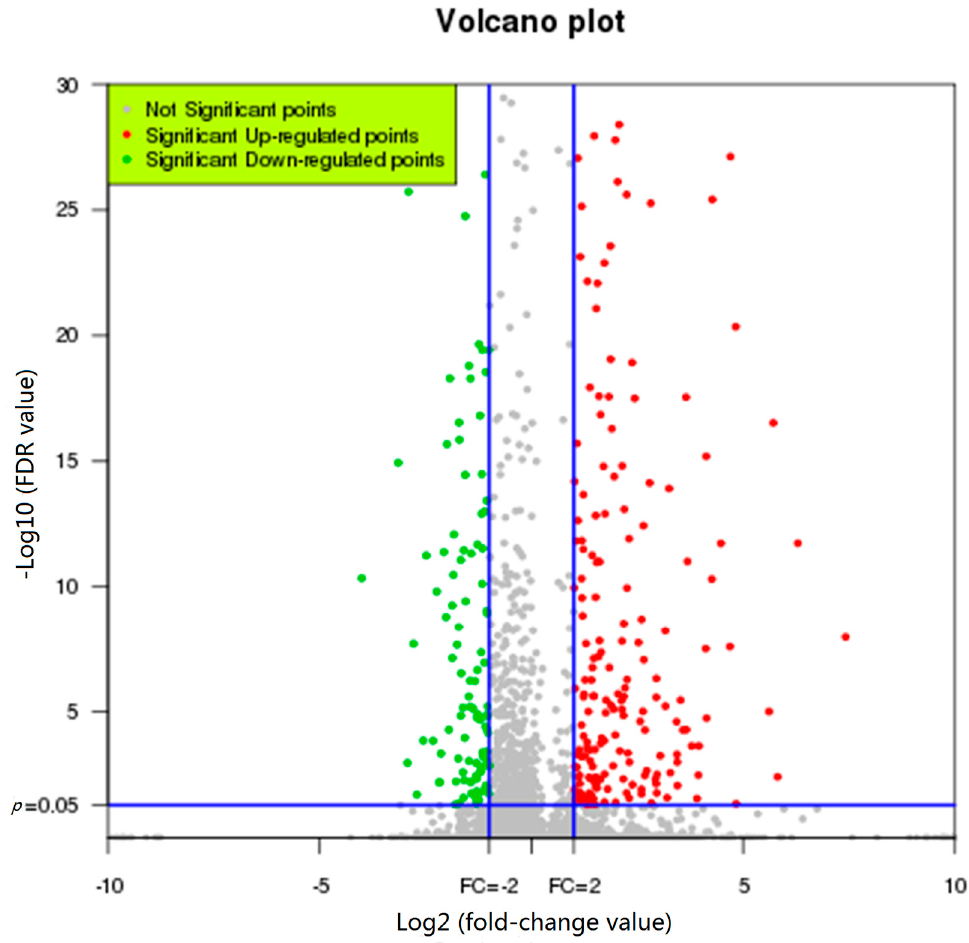
Figure 2. Volcano plot displaying differentially expressed genes between virus-infected and virus-free samples. The y -axis displays to the -log10 of the mean expression value (FDR value), and the x -axis displays the Log2 (fold-change (FC)-value). The red dots represent the up-regulated differentially expressed transcripts between virus-infected and virus-free samples; the green dots represent the transcripts whose expression was down-regulated; and the gray dots indicate genes not showing significant differences.